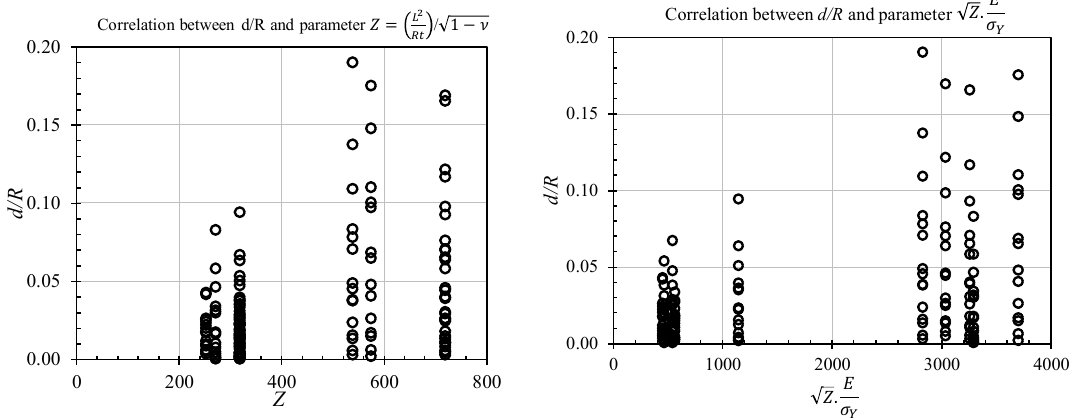
√ Z E σ for the for the ring- Y